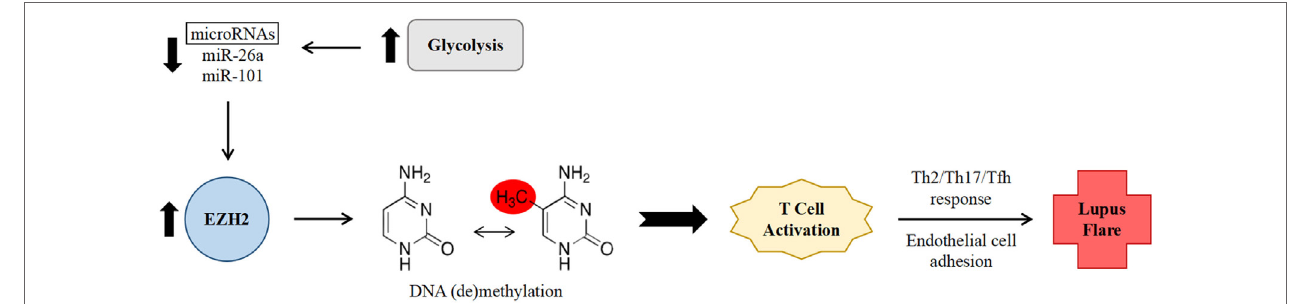
FiGURe 1 | Proposed mechanism of increased systemic lupus erythematosus (SLE) disease activity via enhancer of zeste homolog 2 (EZH2)-mediated epigenetic remodeling within CD4 + T cells. Abnormally enhanced glycolysis in SLE results in decreased levels of the microRNAs miR-26a and miR-101. Decreased microRNA levels leads to lessened downregulation of the expression of transcription factor EZH2. EZH2 in turn promotes deoxyribonucleic acid methylation changes, leading to T cell activation, a non-Th1 effector T cell response, and increased adhesion to endothelial cells, thereby promoting SLE disease